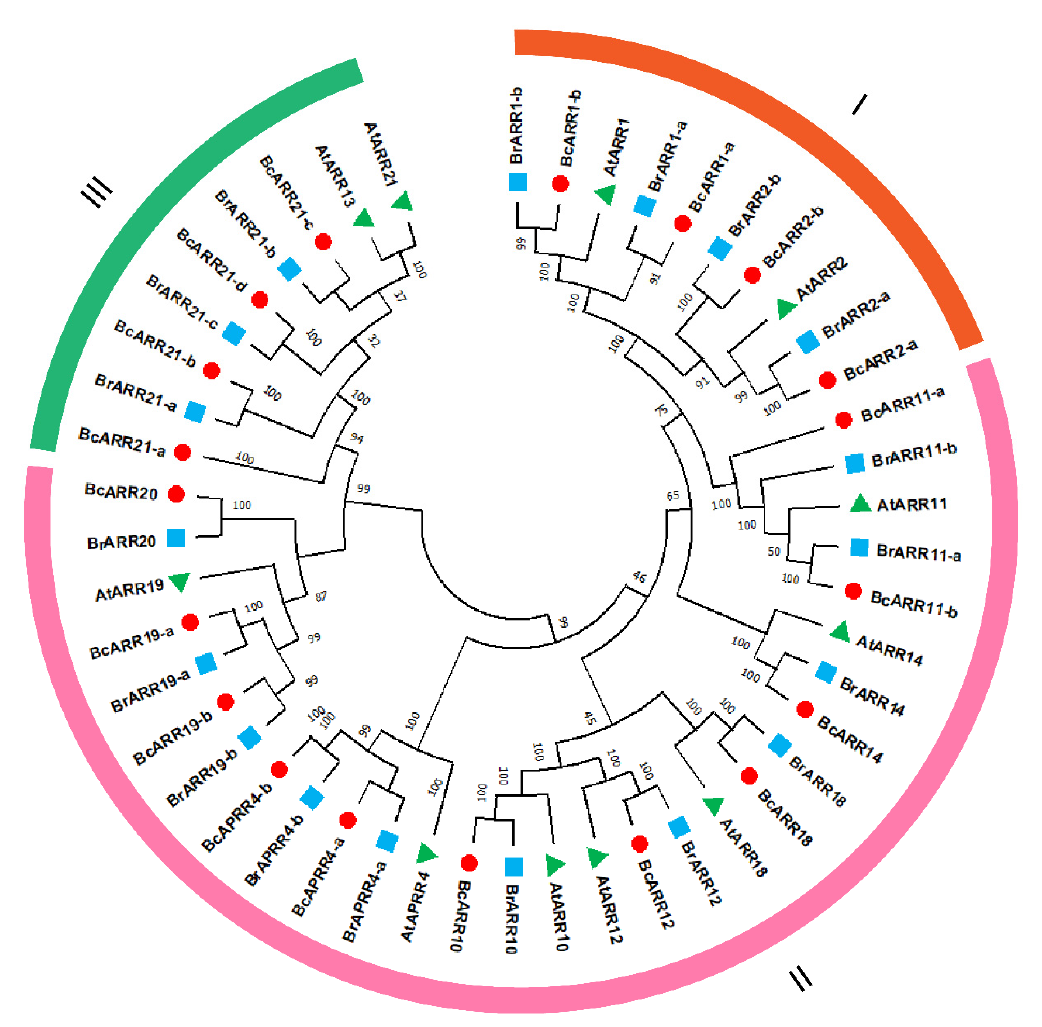
Figure 5. Phylogenetic analysis of the type-B ARR families in Arabidopsis thaliana , Brassica rapa , and Brassica campestris . A neighbor-joining phylogenetic tree was constructed from 48 protein sequences from Arabidopsis thaliana (11), Brassica rapa (18) and Brassica campestris (19). The tree was divided into three subfamilies (subfamilies I, II, and III).